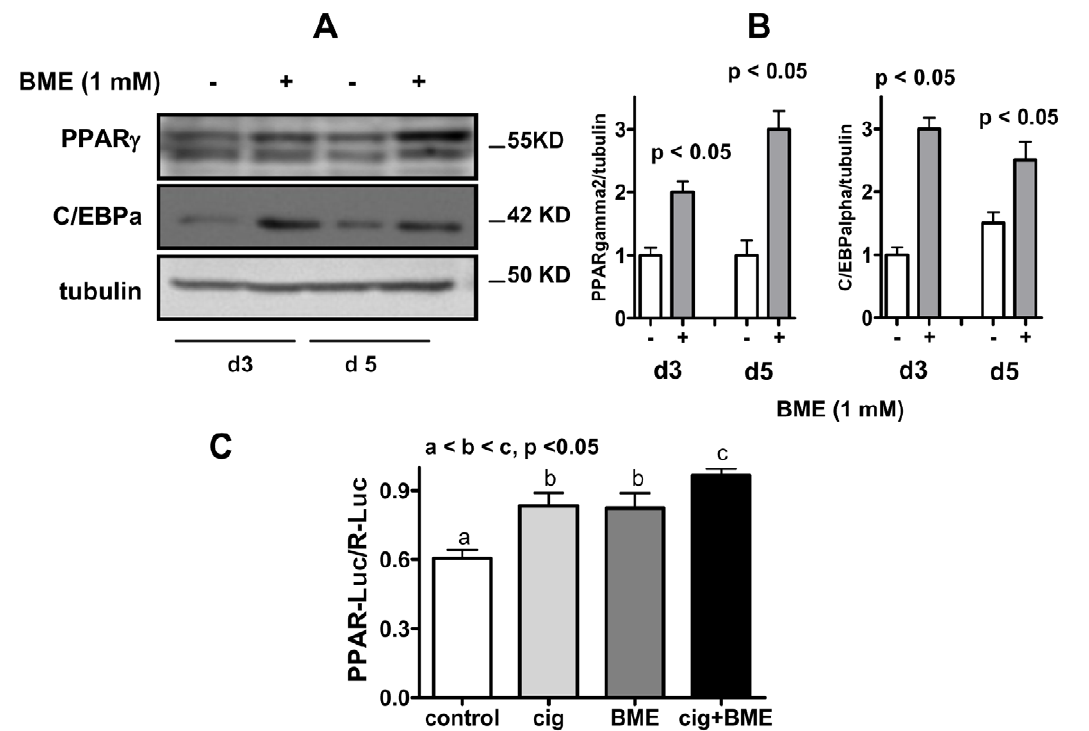
Figure 2. BME increases protein expression of PPARgamma and C/EBPalpha but does not directly regulate their transcription activities. A : representative blot of Western analysis for PPARgamma and C/EBPalpha in F442A cells differentiated without or with BME (1 mM). Cells were harvested on day 3 (d3) and day 5 (d5) after induced to differentiation by insulin and fetal bovine serum. B : quantification of PPARgamma and C/EBPalpha protein expression normalized to the loading control tubulin. Of note, although both PPARgamma1 (lower band) and PPARgamma2 (upper band) were detected, quantification was only done for PPARgamma2 because only this protein is adipocyte-specific. C : PPARgamma-driven luciferase activity in HEK293 cells treated with or without BME (1 mM) or ciglitazone (0.001 mM). Results are means + / 2 se (N=3).